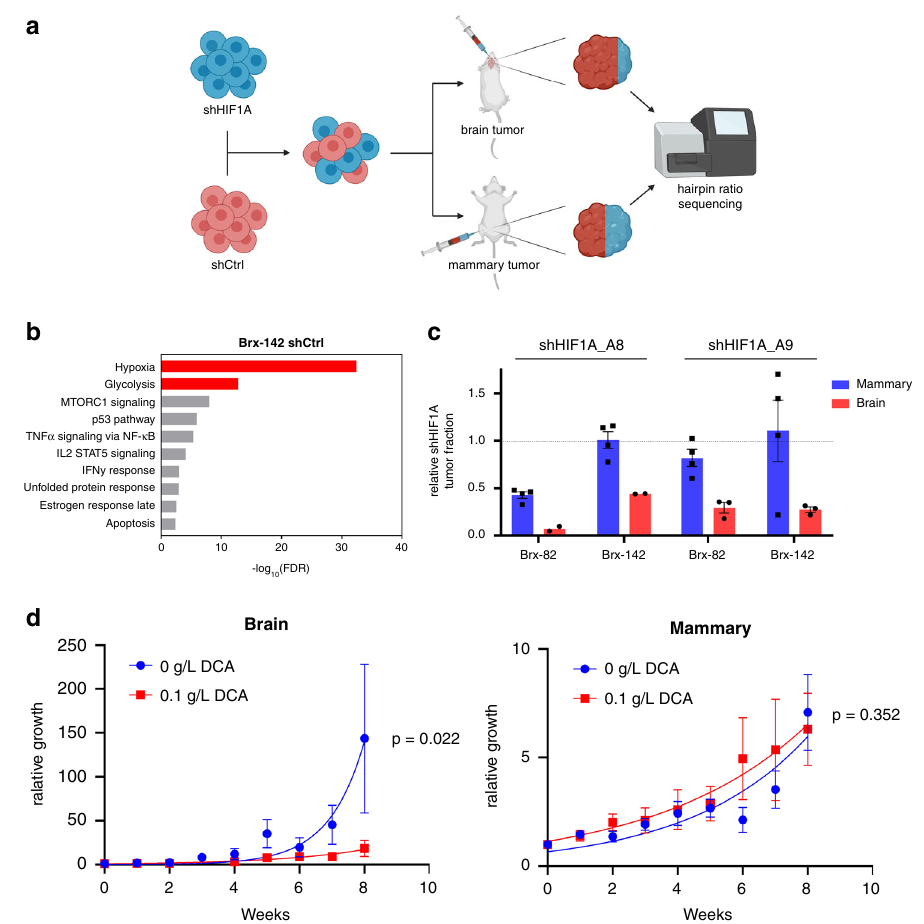
Fig. 5 Hypoxic signaling is preferentially required for brain versus breast tumor growth. a Schema illustrating mixing experiments using shCtrl and shHIF1A CTCs to establish brain and mammary tumors. b GSEA of transcripts differentially expressed in Brx-142 shCtrl versus shHIF1A_A8 cells (fold change >2; FDR < 0.25). The most enriched Hallmarks of Cancer gene sets from the Broad Molecular Signatures Database and associated FDR values are shown. Hypoxia and glycolysis genesets are highlighted. c shHIF1A tumor fraction as compared to input fraction in brain or breast tumors from Brx-82 or Brx-142 mixing experiments. shHIF1A tumor fraction was determined via next-generation sequencing for the hairpin sequences corresponding to shCtrl, shHIF1A_A8, and shHIF1A_A9 (shHIF1A_A8 brain: n = 2; shHIF1A_A9 brain: n = 3; all mammary: n = 4). Dotted line indicates unchanged shHIF1A and shCtrl fractions from input. d Brain or mammary tumor luminescence monitored following stereotactic injection of Brx-82 cells (brain 0 g/L DCA: n = 8; brain 0.1 g/L DCA: n = 4; all mammary: n = 4). Mice were treated for 8 weeks with 0.1 g/L DCA or vehicle delivered in drinking water. P values